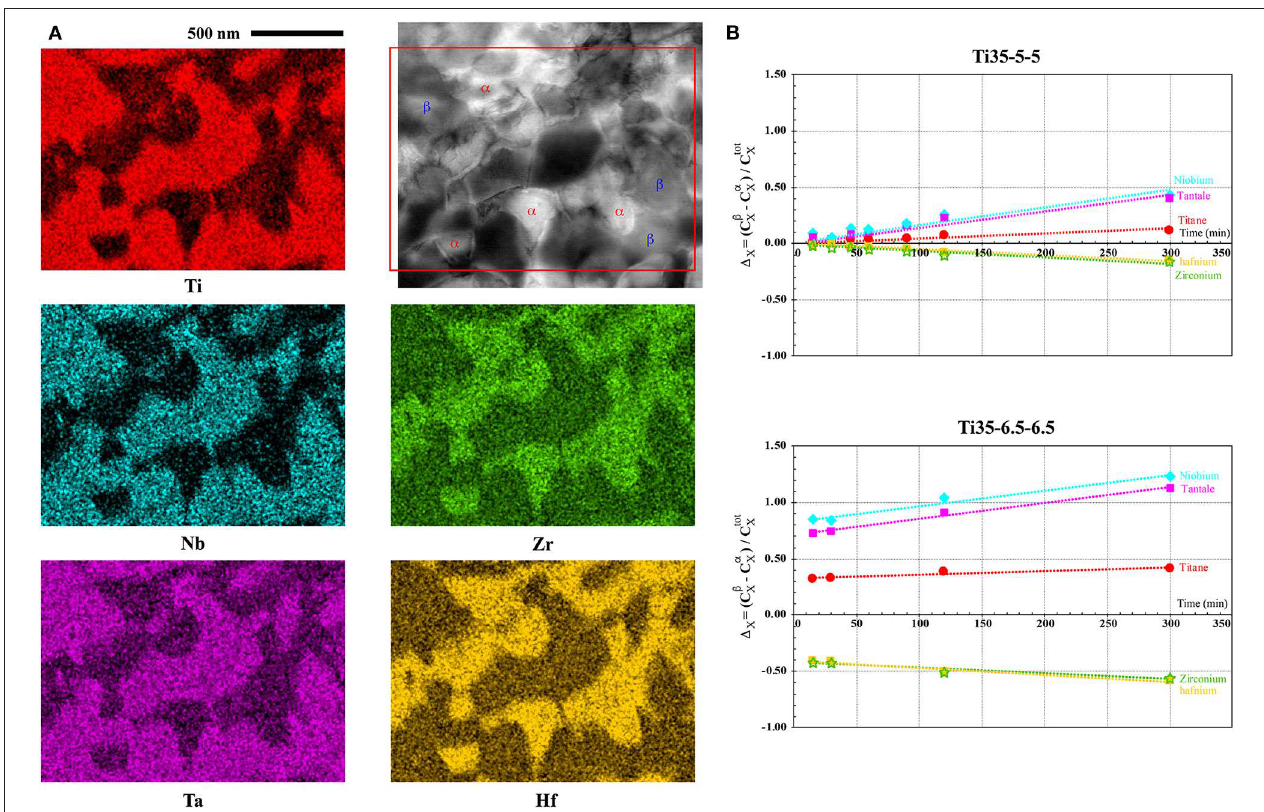
FIGURE 4 | (A) Scanning transmission electron microscopy (STEM) element maps associated with the bright-field image for the Ti35-5-5 alloy annealed 30min at 650 ◦ C. (B) 1 X parameter vs. the holding time at 650 ◦ C for both Ti35-5-5 and Ti35-6.5-6.5. The colors (B) correspond to the elemental identification of (A) , that is, Ti in red, Nb in cyan, Ta in purple, Zr in green, and Hf in